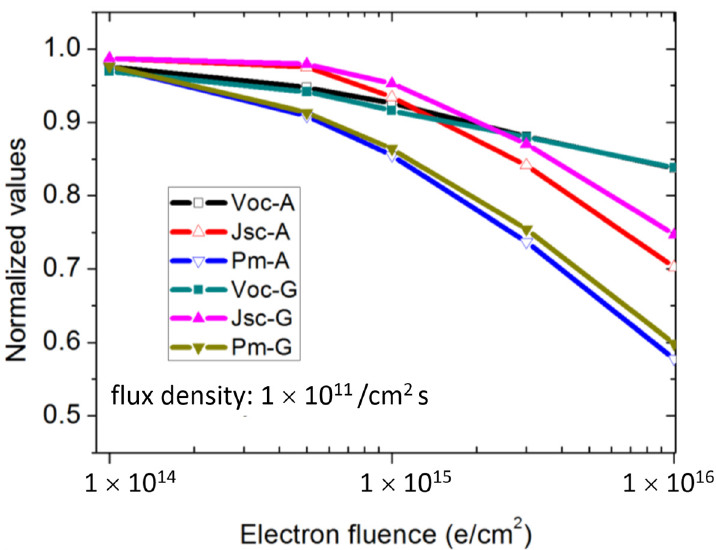
Figure 6. J sc , V oc , and P max values of Sample A and G solar cells irradiated by 1 MeV electron beam with flux density of 1 × 10 11 e/cm 2 .